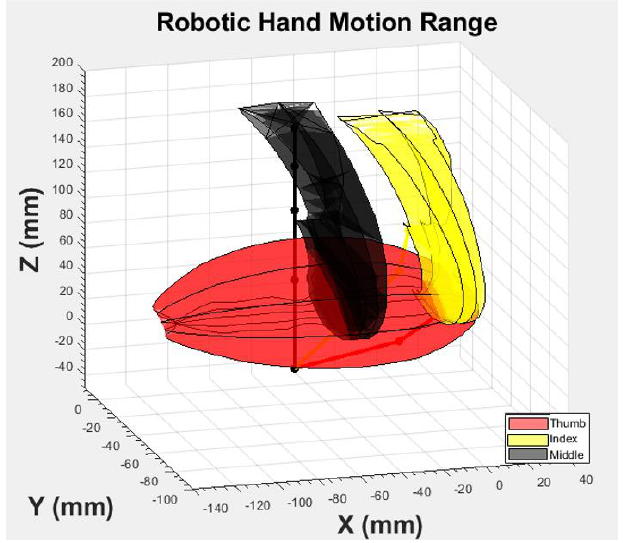
Figure 9. Graphical representation of the motion of the fingertips for each design during actuation.